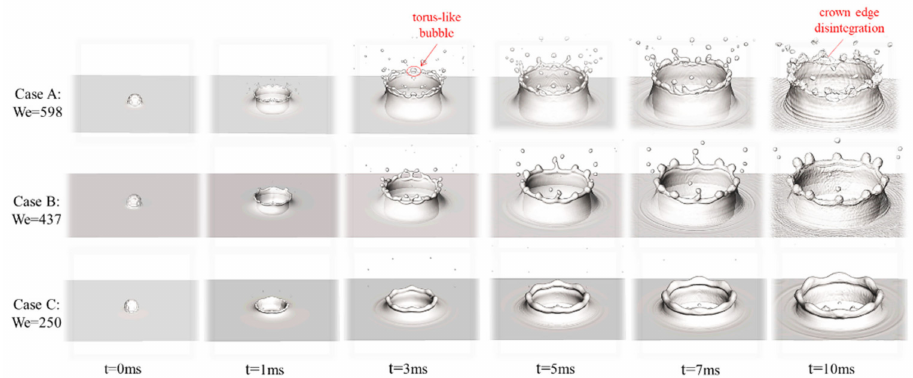
Figure 5. The three-dimensional evolution of the droplets impacting on the film at different times for case A, B, and C.